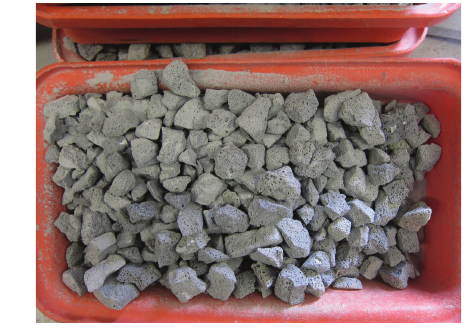
Figure 1: Close-up photo of FG.